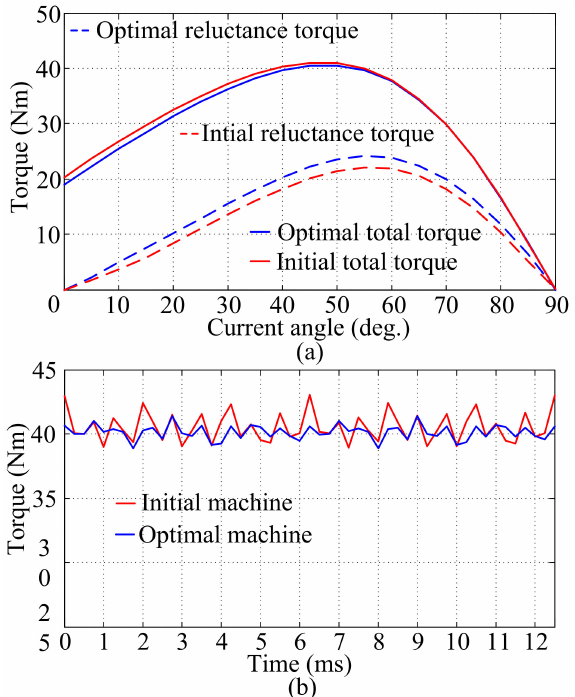
Figure 11. Torque performances of the machine before and after optimization. ( a ) Torque vs. current angle. ( b ) Torque ripple